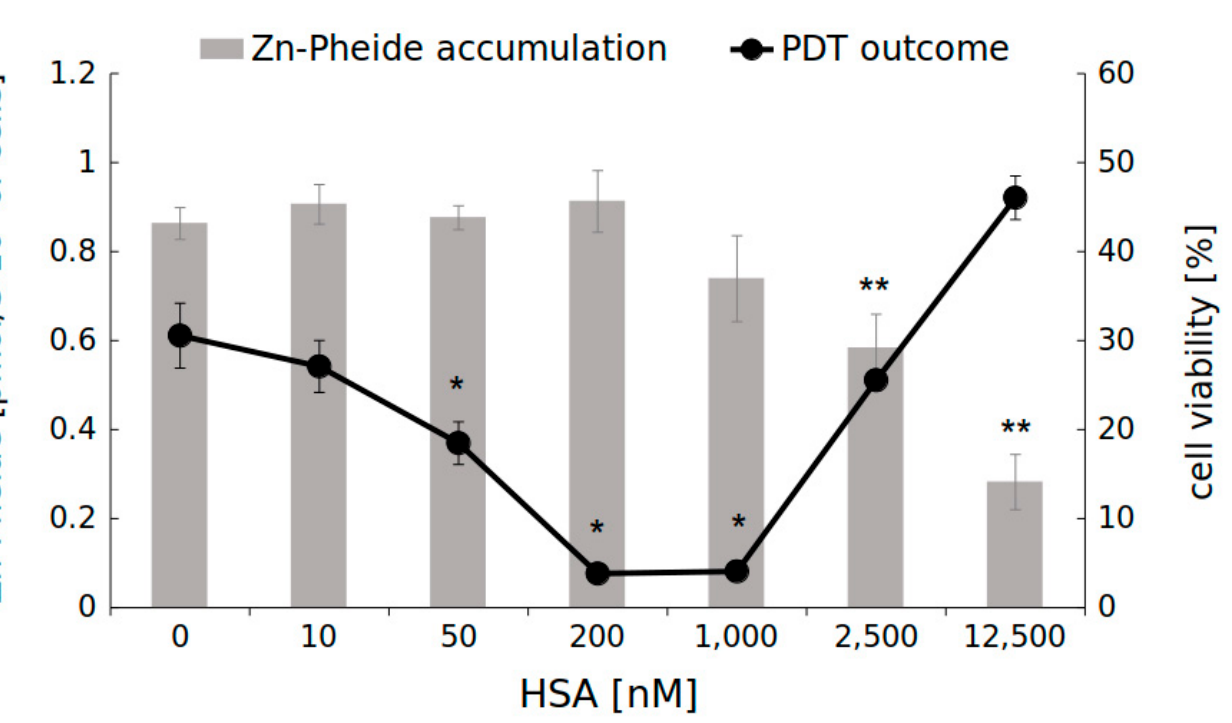
Figure 4. Accumulation of Zn-Pheide (50 nM) in HUVEC cells and the corresponding photodynamic effect at various concentrations of HSA. The results are presented as mean ± SD, n = 3. Single asterisks (*) indicate significant differences in cell viability compared to HSA-free cells ( p < 0.05). Double asterisks (**) indicate significant differences in Zn-Pheide level compared to HSA-free cells ( p < 0.05).